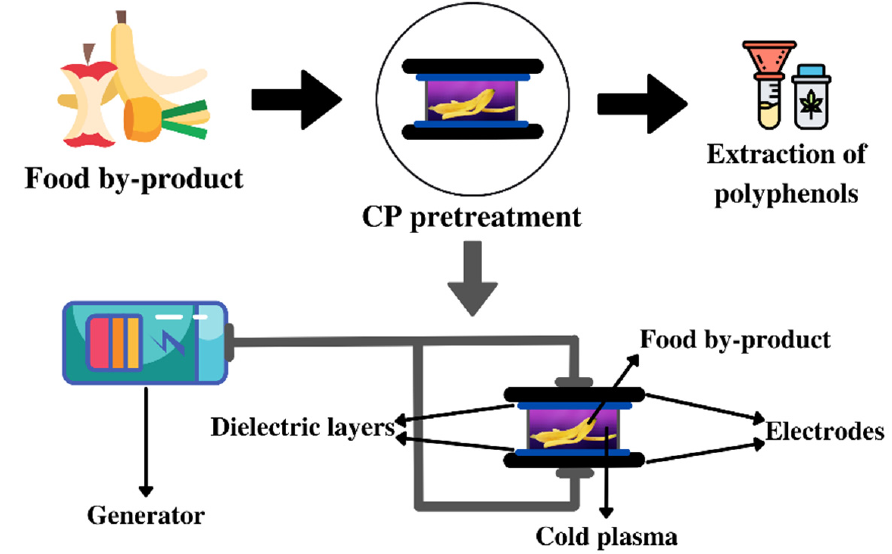
Figure 9. Simplified schematic of extraction of polyphenols using CP pretreatment.